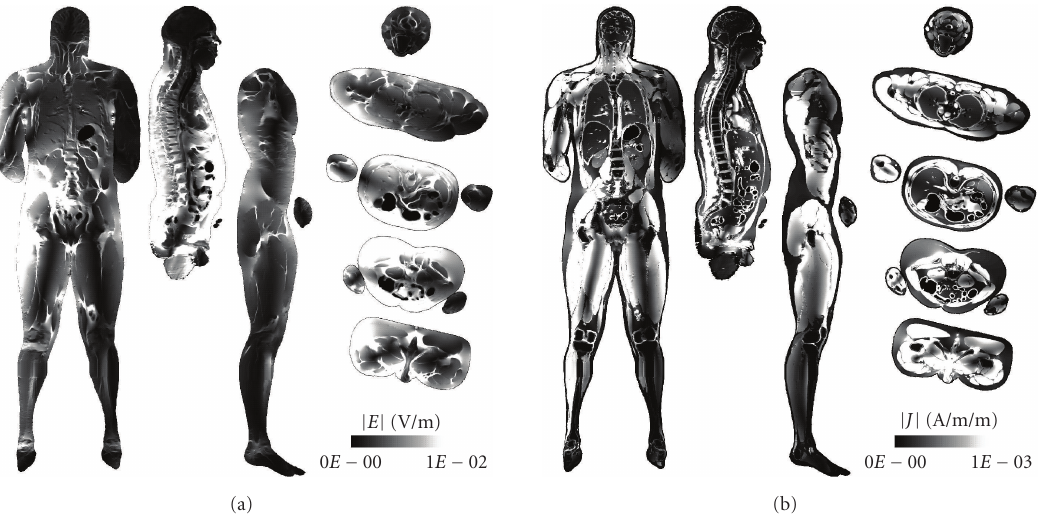
Figure 6: Coronal, sagittal and axial distributions of (a) electric field and (b) current density induced in the 1mm-resolution male body model during gradient pulsing. Figure 5(a) illustrates the body posture of the model relative to the gradient